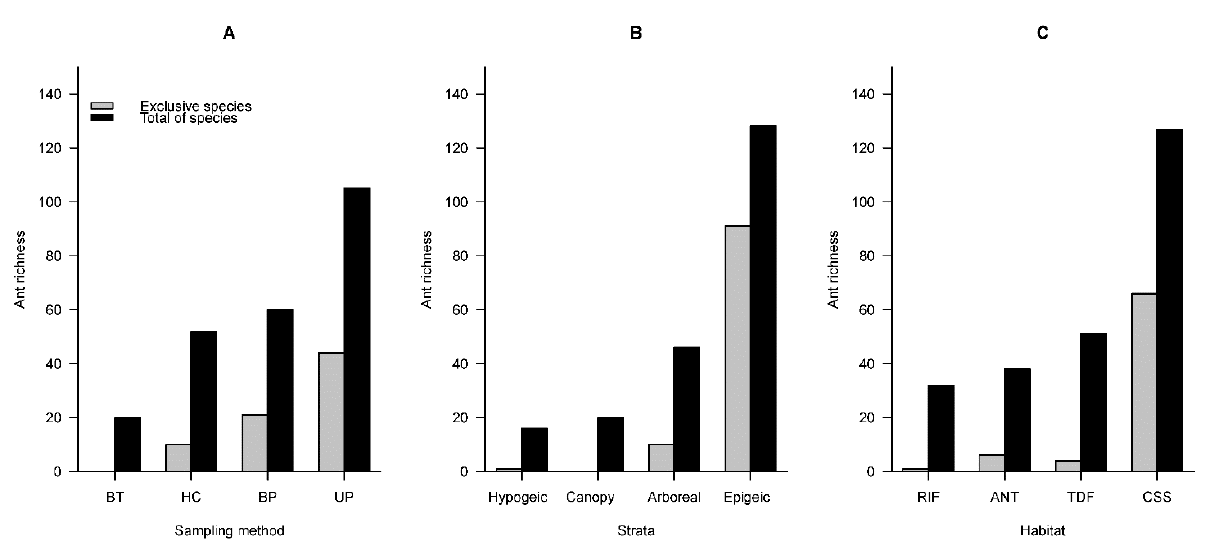
Fig 2 . Graphs representing the number of exclusive (grey) and total (black) species according to: (A) sampling methods, (B) strata, and (C) habitats. BT = Beating, HC = Hand collection, BP = Baited pitfall traps, UP = Unbaited pitfall traps, RIF = Riparian Forest, ANT = Anthropogenic habitats, TDF = Tropical Dry Forest, CSS = Cerrado sensu stricto